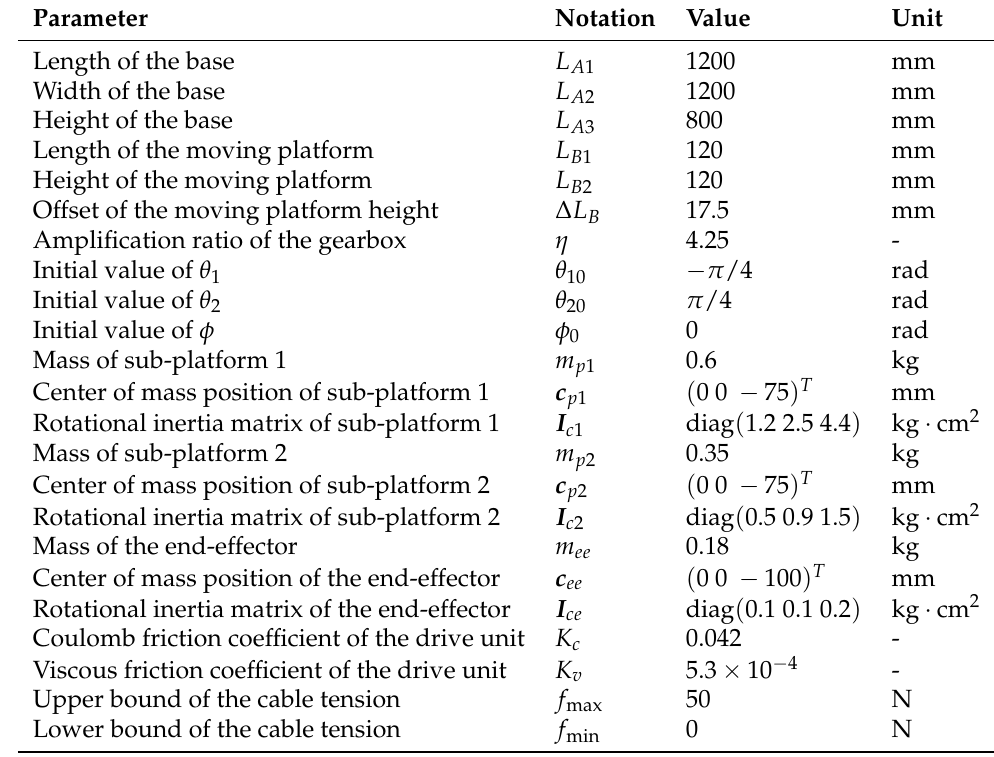
Table 1. Kinematic and dynamic parameters of the